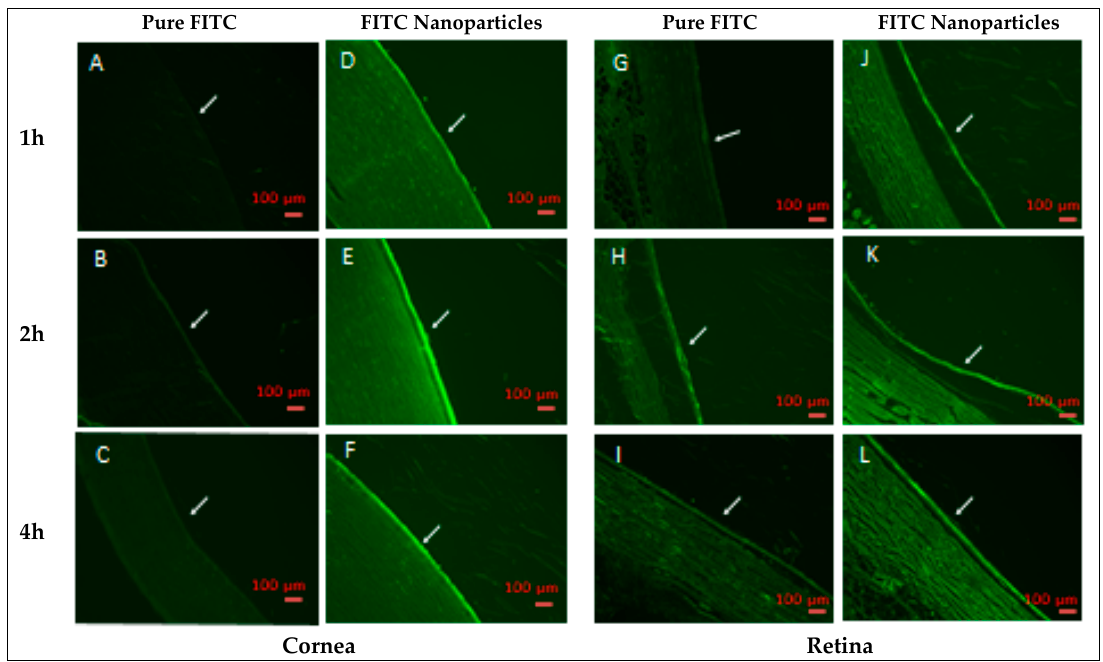
Figure 9. Images of a florescence laser microscope show eye sections on New Zealand white rabbits’ eyes after treatment with the ISHG formulation containing FITC-nanoparticles and the ISHG for- mulation loaded with pure FITC after 1, 2, and 4 h. Cornea sections (A-F) and retina sections (G-L) of rabbits’ eyes from both groups (arrows point to fluorescence). Abbreviations: FITC, florescence isothiocyanate; ISHG, in situ hydrogel.